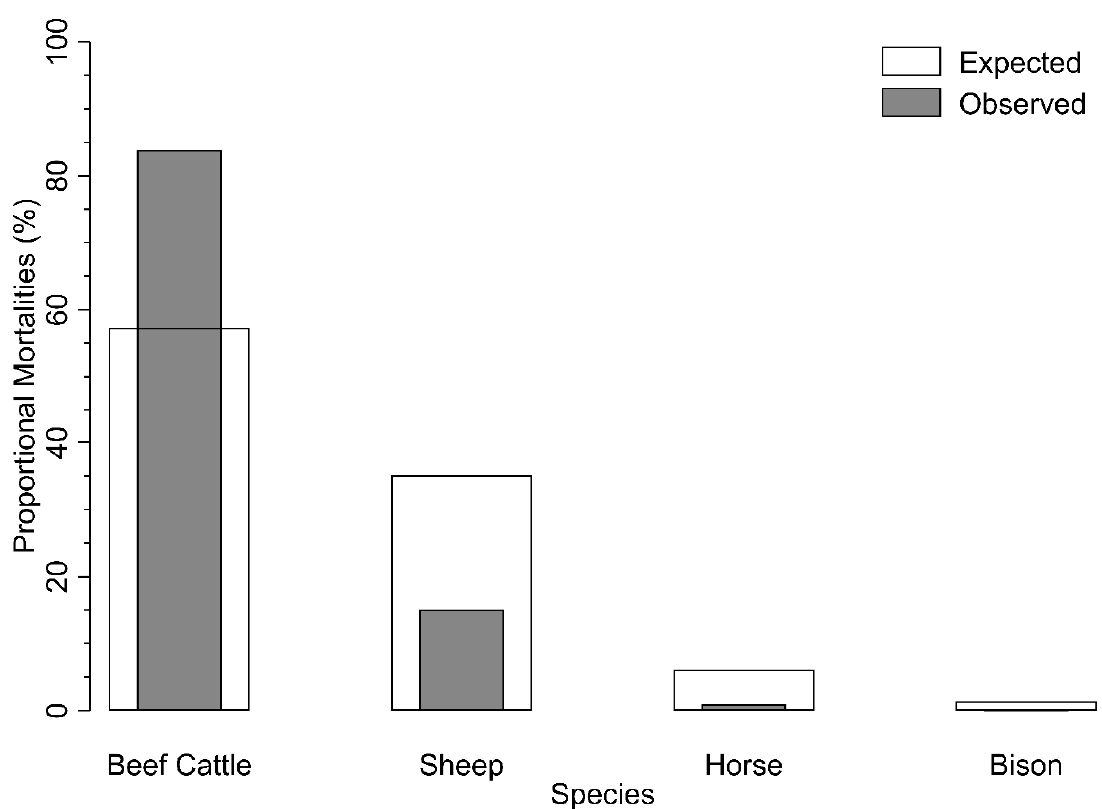
Figure 1. Histogram of expected (%; hollow fill) and observed (%; gray fill) proportional mortalities (%) of event total death loss by species including beef cattle ( Bos taurus ), sheep ( Ovis aries ), horse ( Equus caballus ), and bison ( Bison bison ) from the Atlas Blizzard affected counties in South Dakota of October 2013. Note: difference in the distribution of the expected and observed histograms is tested with χ 2(gof) in Table 2. Table 2. Output summary table of McNemar chi-squared ( M χ 2 ) tests and Chi-squared goodness-of- fit ( χ 2(gof) ) tests comparing observed versus expected death loss of cattle, sheep, horse, bison, and across all species during Blizzard Atlas in early October 2013.